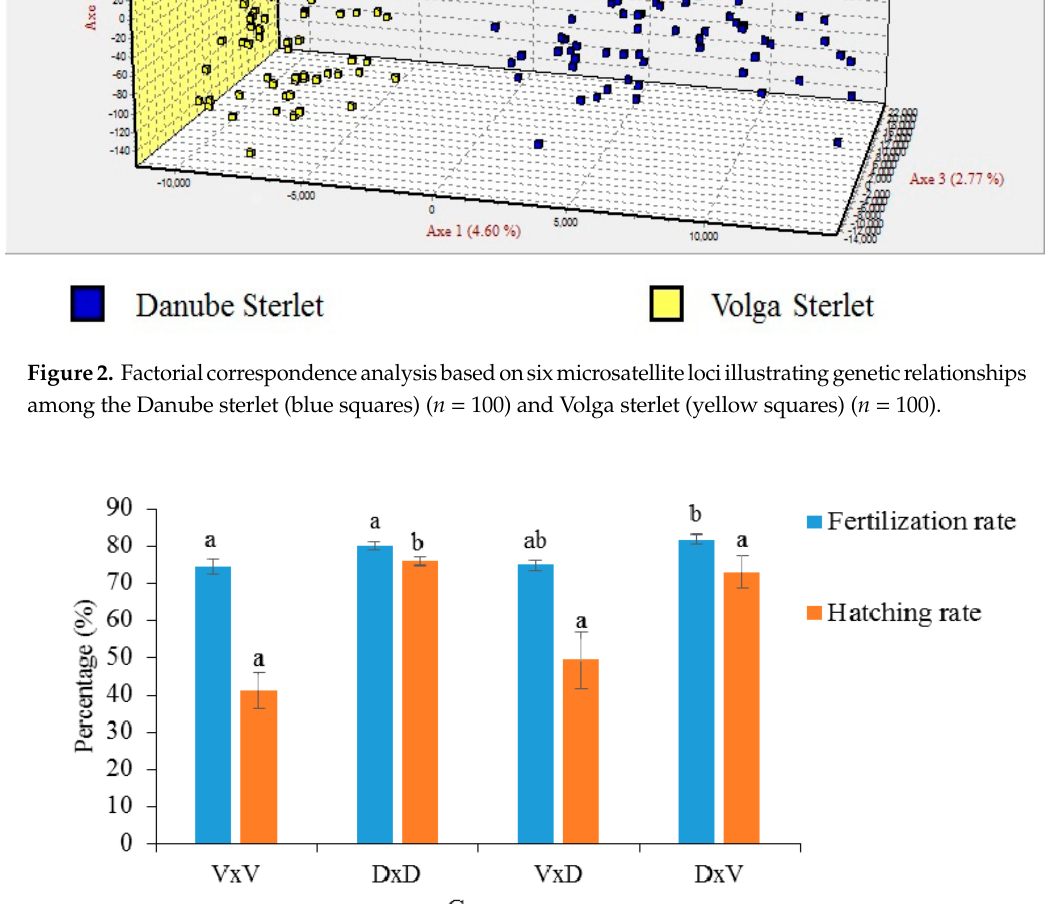
Figure 2. Factorial correspondence analysis based on six microsatellite loci illustrating genetic relationships among the Danube sterlet (blue squares) ( n = 100) and Volga sterlet (yellow squares) ( n = 100).